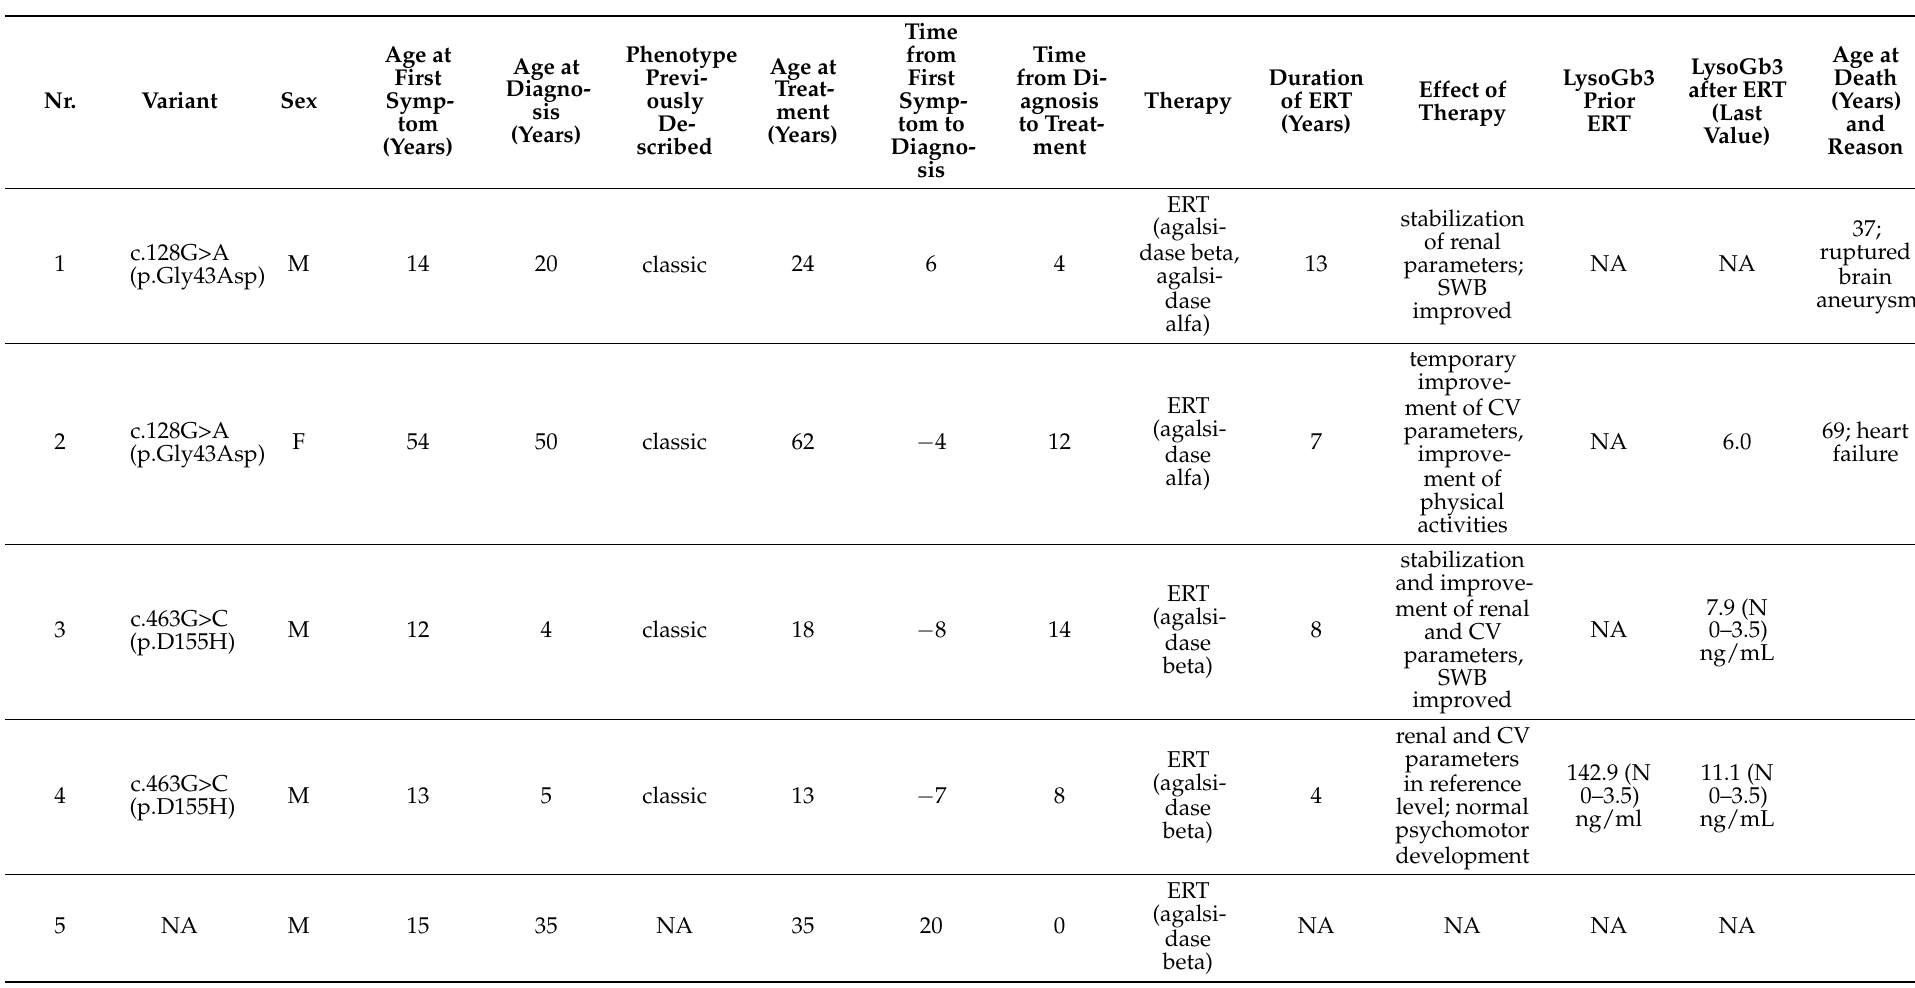
Table 2. The characteristics of the treated